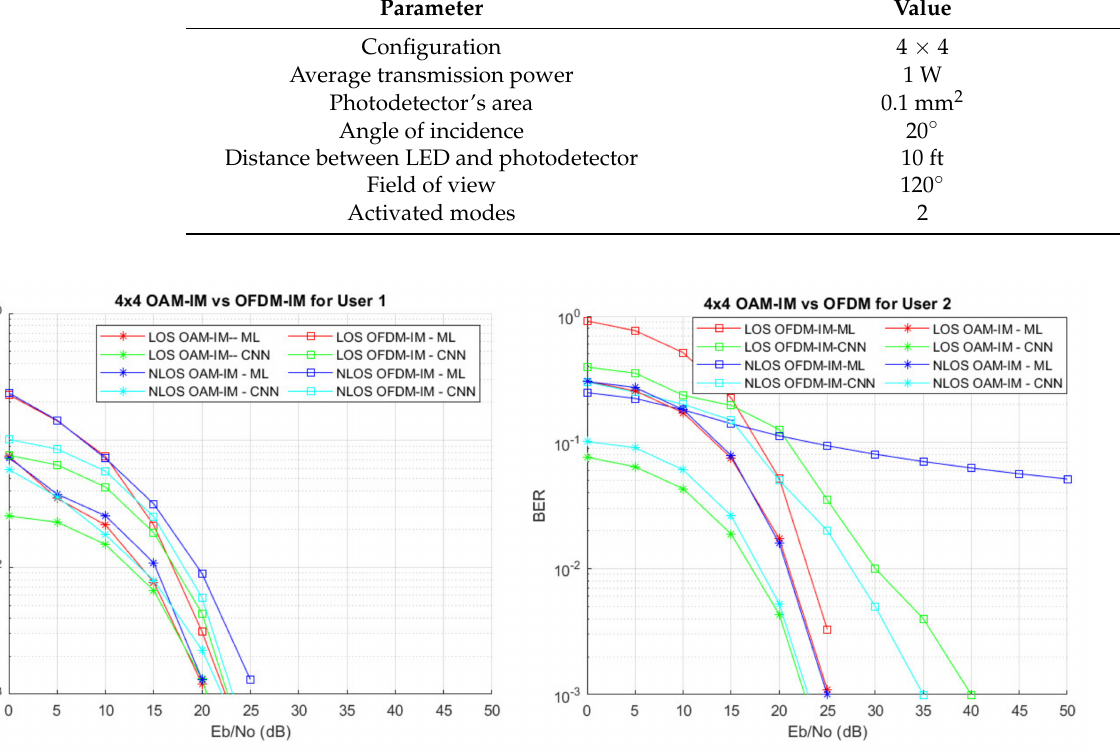
Figure 9. User 1 and user 2 BER of OFDM-IM and OAM-IM for LoS/NLoS VLC